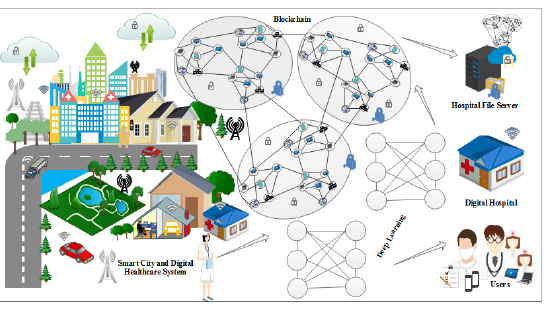
Figure 7. Proposed DL Module for our Blockchain-based IoT